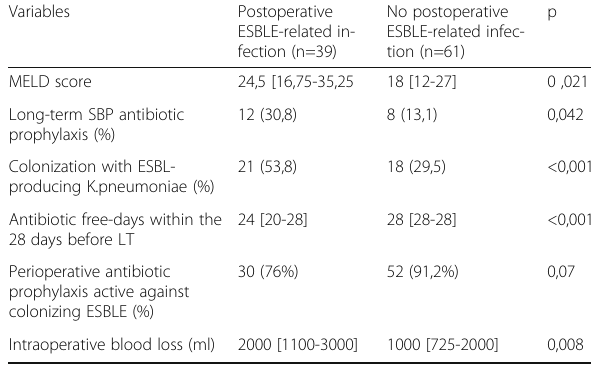
Table 1 (abstract 0078). Factors associated with ESBLE-related infections in patients with prior ESBL rectal colonization